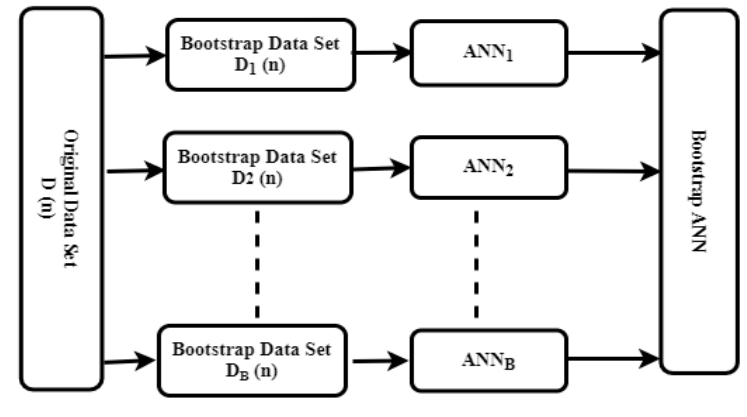
Figure 6. Bootstrap ANN architecture.